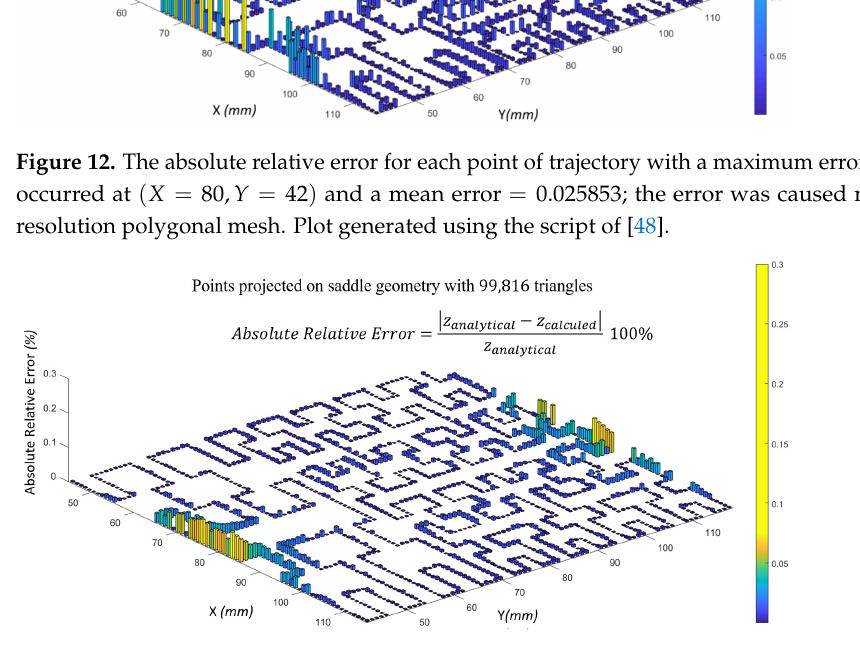
Figure 13. The absolute relative error for each point of trajectory on higher resolution polygonal mesh with a maximum error of 0.075592% occurred at ( X = 83, Y = 42 ) and a mean error = 0.007551. Plot generated using the script of